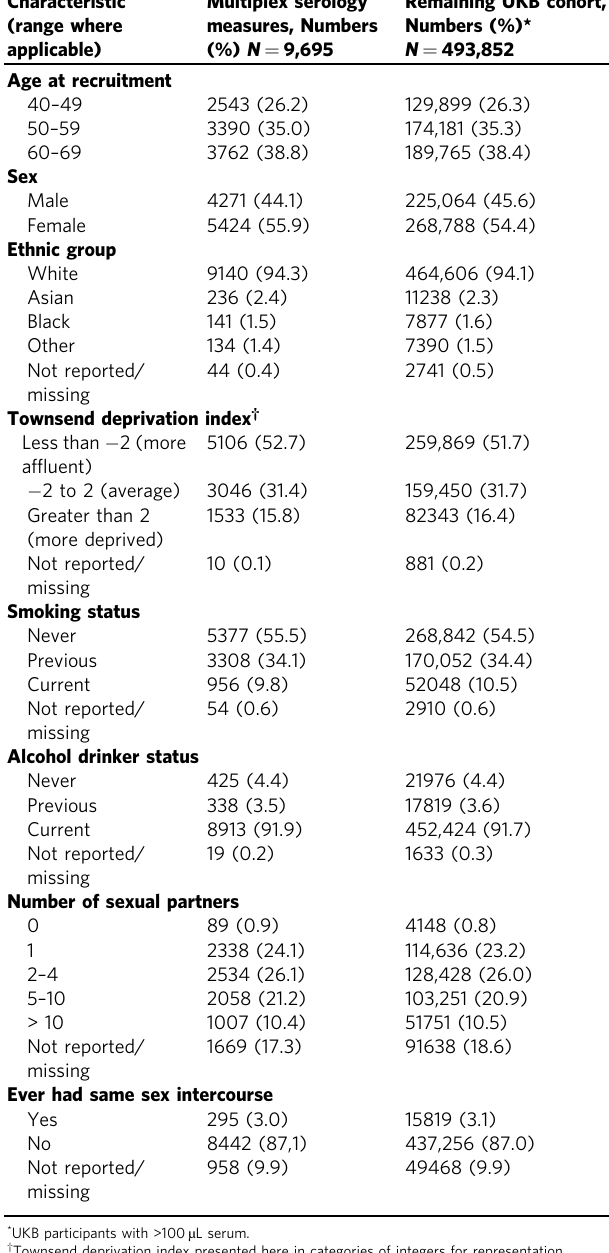
* UKB participants with >100 µ L serum. † Townsend deprivation index presented here in categories of integers for representation purposes but modelled in